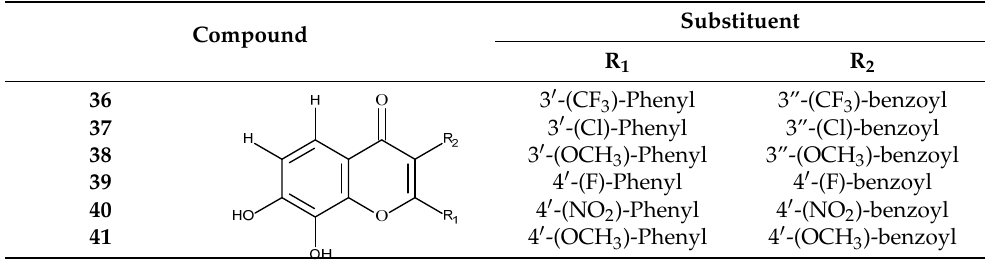
Table 2. Substitution scheme of compounds 36 – 41 . Compound